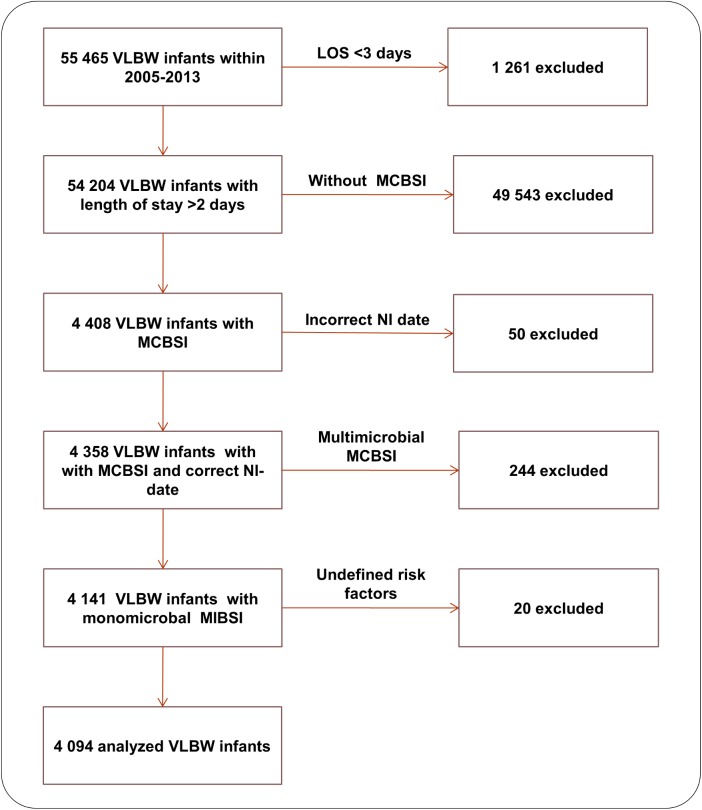
Exclusion flow chart.LOS, length of stay; VLBW, very low birth weight; NI, nosocomial infection; MCBSI, microbiological confirmed bloodstream infection.